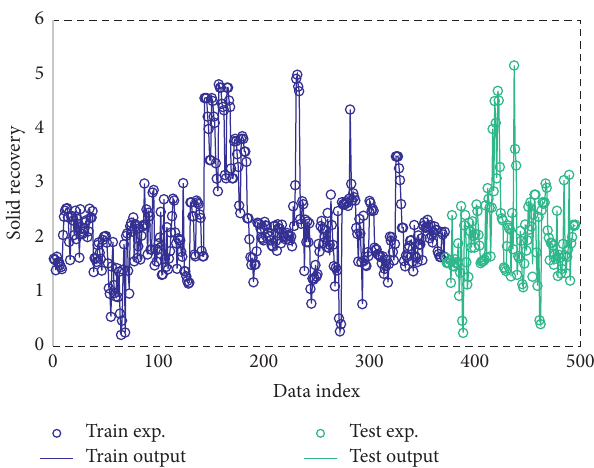
Figure 4: Simultaneous viewing of real and modeled SR output data.